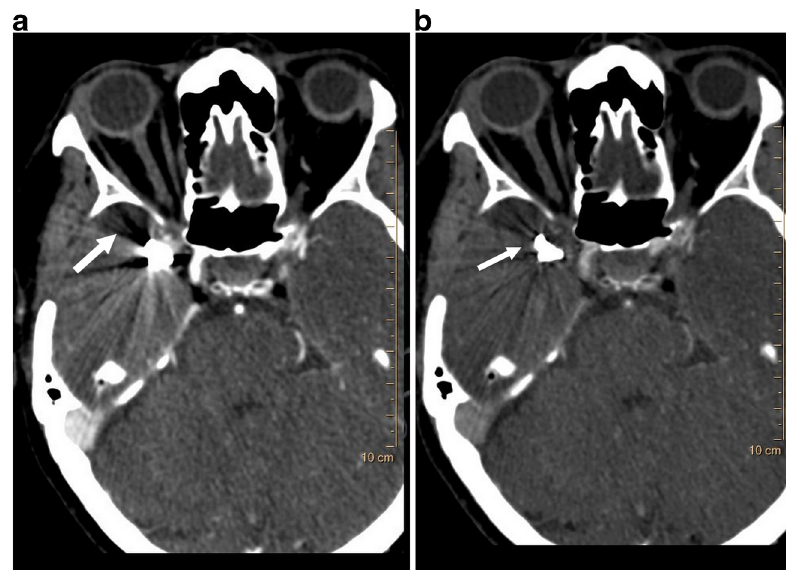
Fig. 6 Metallic artefact reduction. ( a ) Axial 120-kVp routine diagnostic CT image through the head shows dense metallic opacity in the right temporal region ( arrow ). ( b ) 120- keV VMI at the same level shows significant improvement in the metallic artefact ( arrow